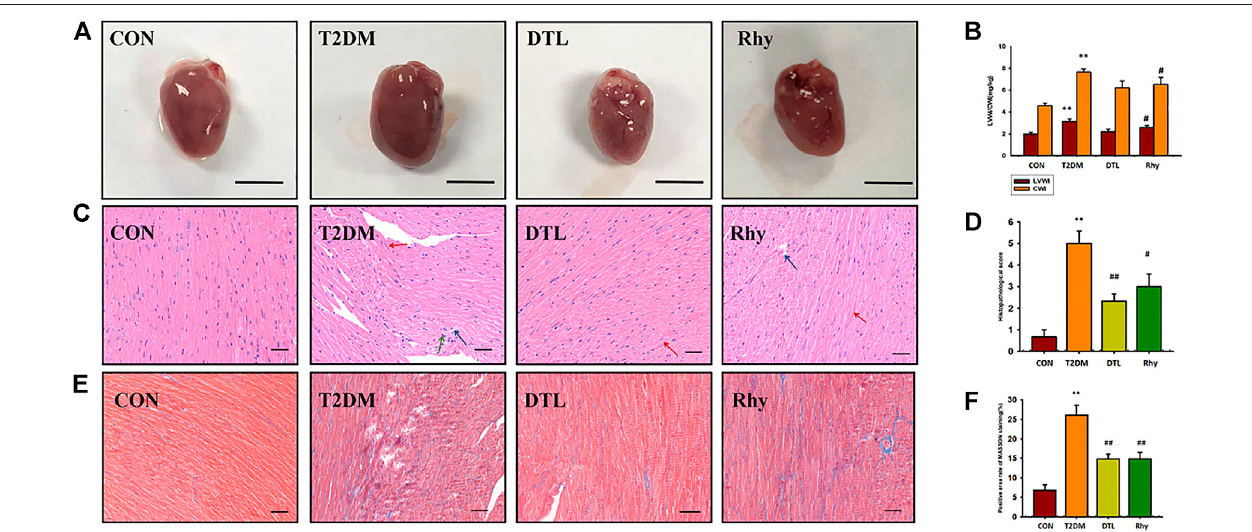
FIGURE 4 | Effect of rhynchophylline on cardiac appearance and morphology. (A) Representative heart photographs ofeach group. (B) The left ventricular weight index (LVWI) and cardiac weight index (CWI). (C) Representative sections (magni fi cation, ×400) of cardiac tissue morphology stained by hematoxylin and eosin in each group. (D) Pathology scores; (E) Representative sections (magni fi cation, ×400) of cardiac tissue morphology stained by Masson ’ s trichrome stain in each group; (F) Positive area rate of MASSON staining. Values are presented as mean ± standard error of the mean. ** p < 0.01 vs. control group; # p < 0.05 vs. type 2 diabetes mellitus group.